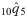
Ridge plots of sub-national estimates of 10q^5 for Ethiopia (2008-11) and Nigeria (2007-10, 2015-2018).